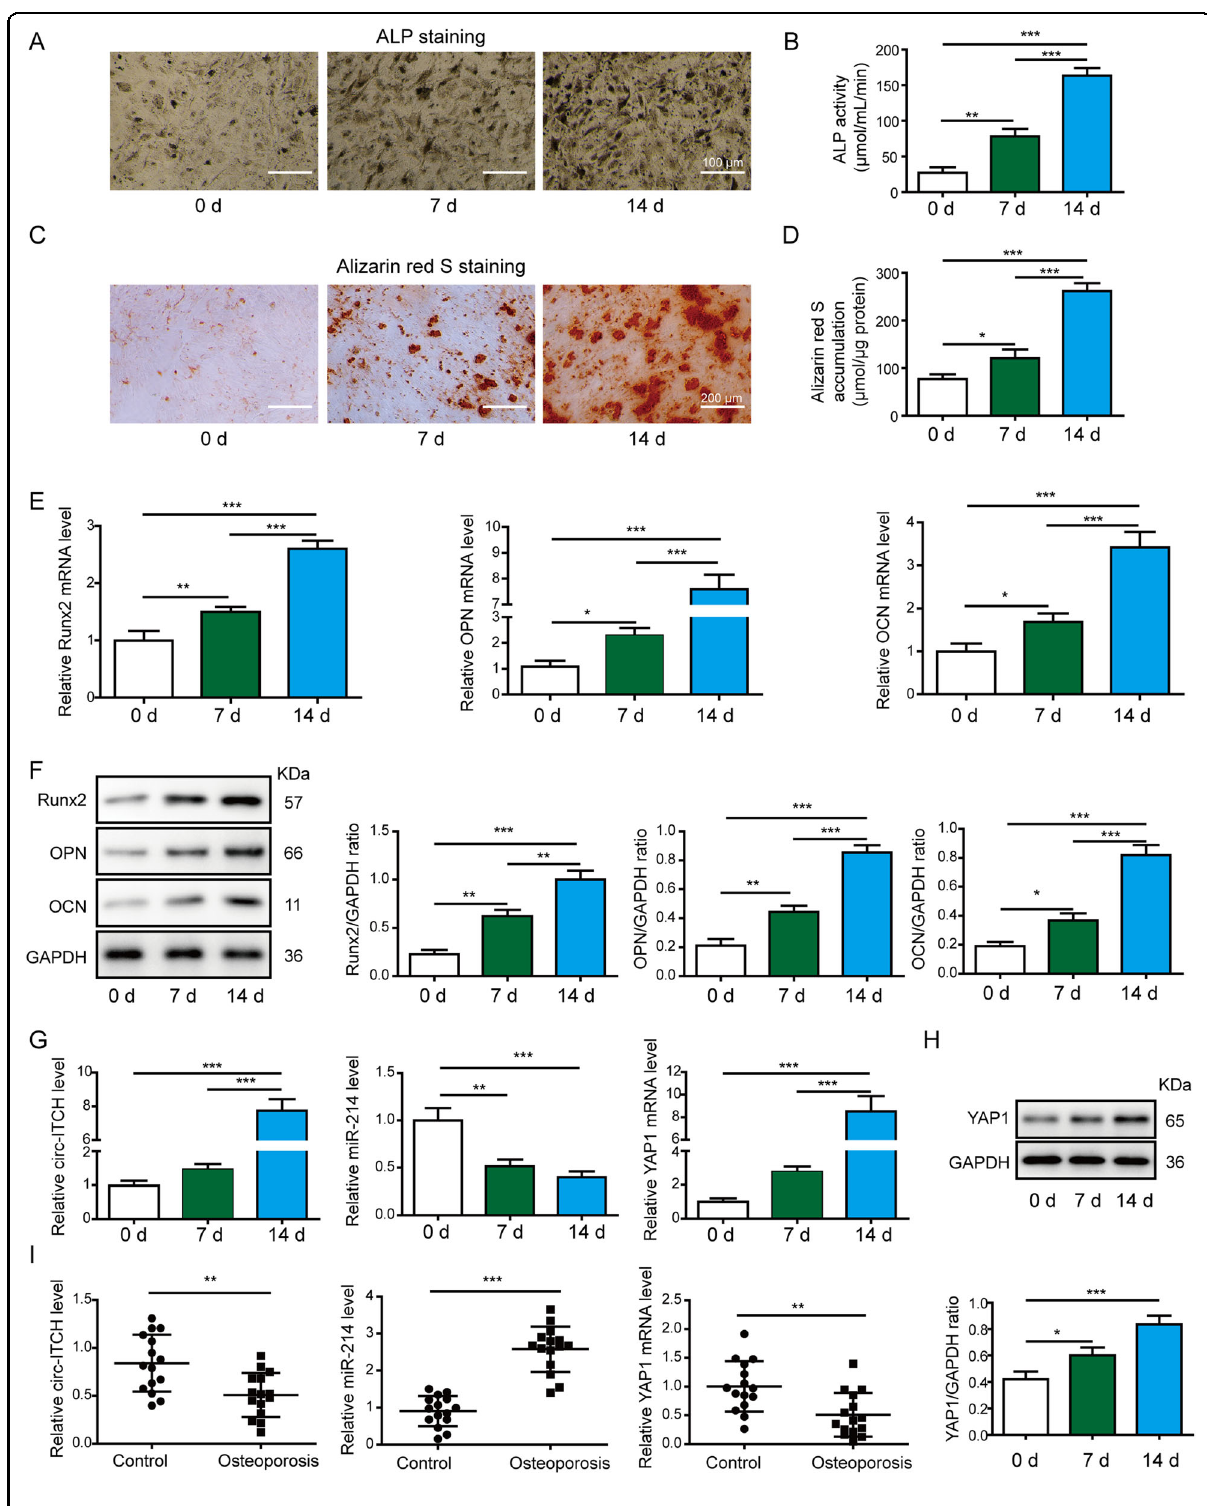
Fig. 1 (See legend on next